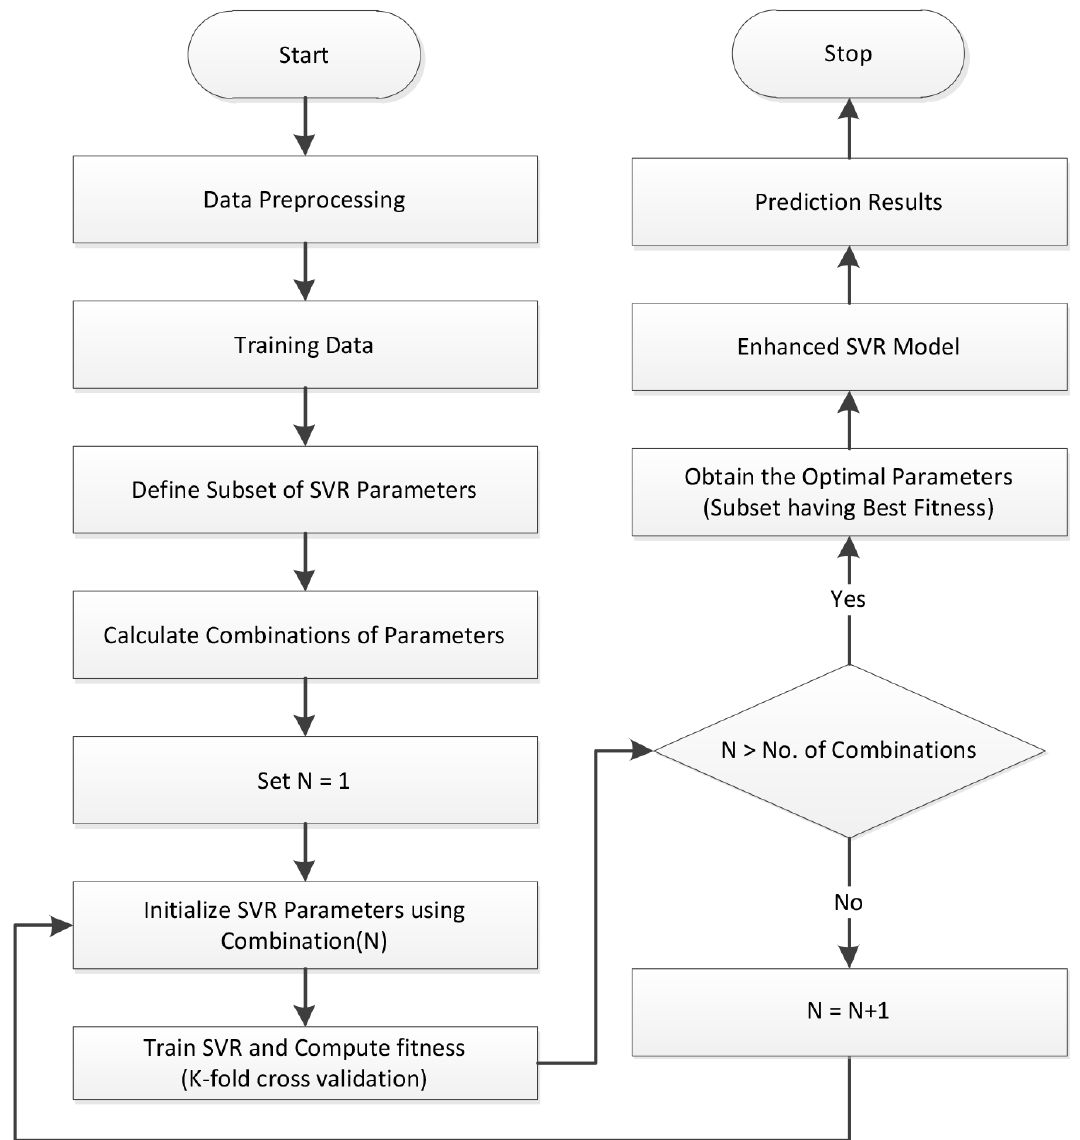
Figure 3. Enhanced Support Vector